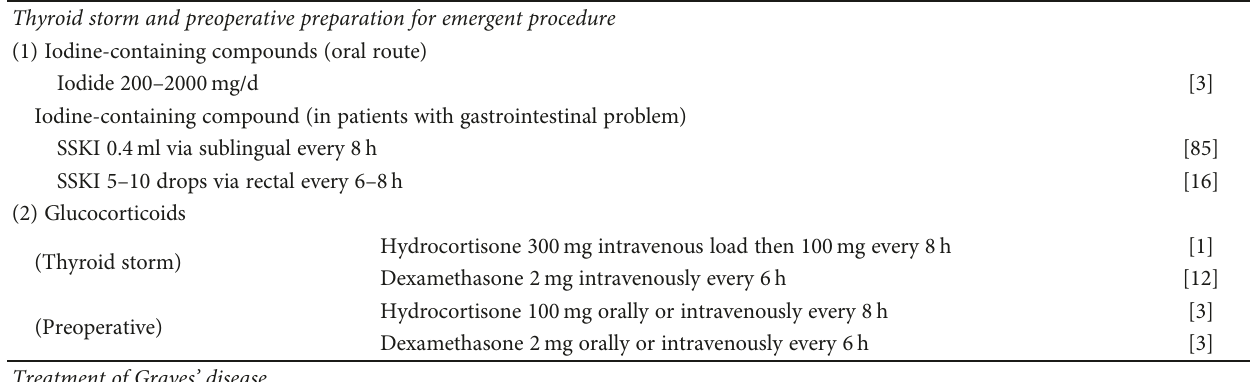
Table 1: Nonthionamide antithyroid drug